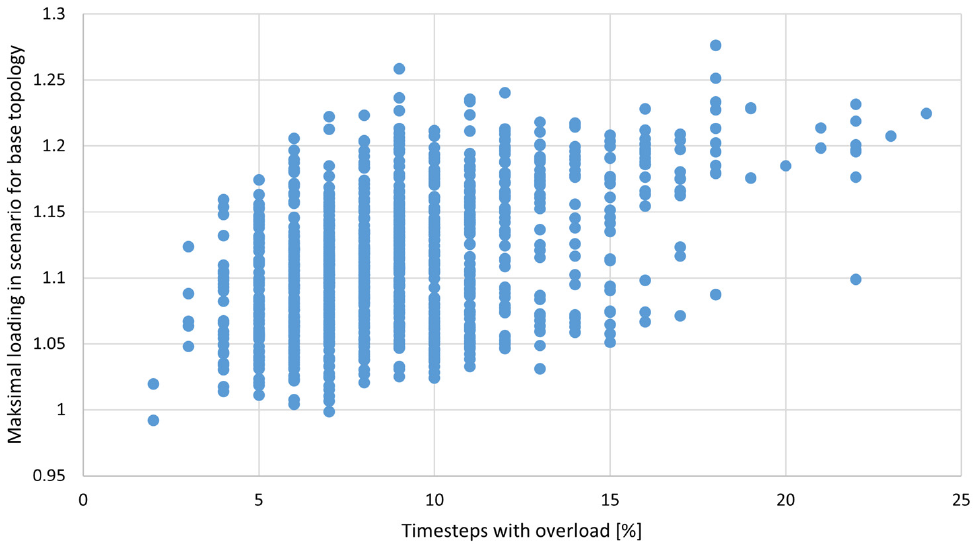
Figure 4. Analysis of highest loading and percentage of timestep with loading of ≥ 0.95 for each of 1004 scenarios.